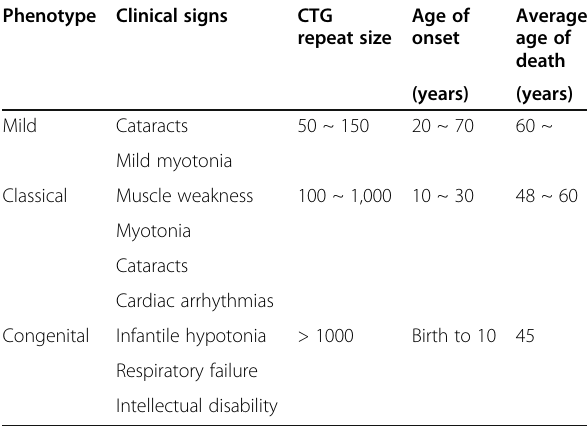
Table 1 Summary of the clinical phenotypes and CTG repeat lengths in myotonic dystrophy type